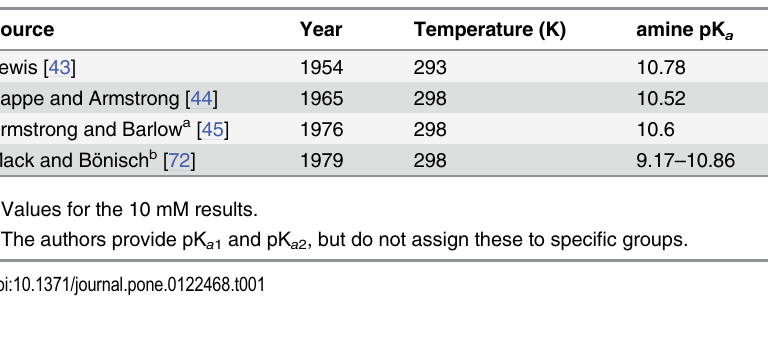
Table 1. Summary of experimental pK a results from the